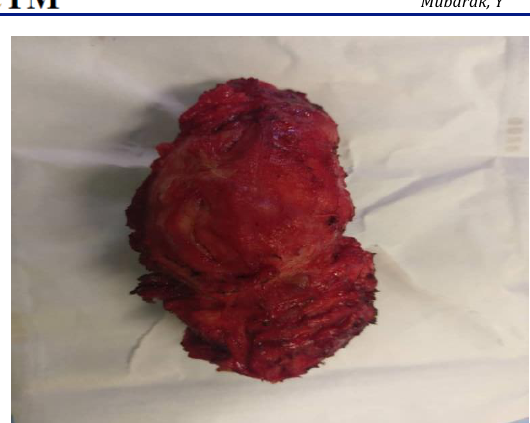
3: Chondroblastic osteosarcoma macroscopic sampling